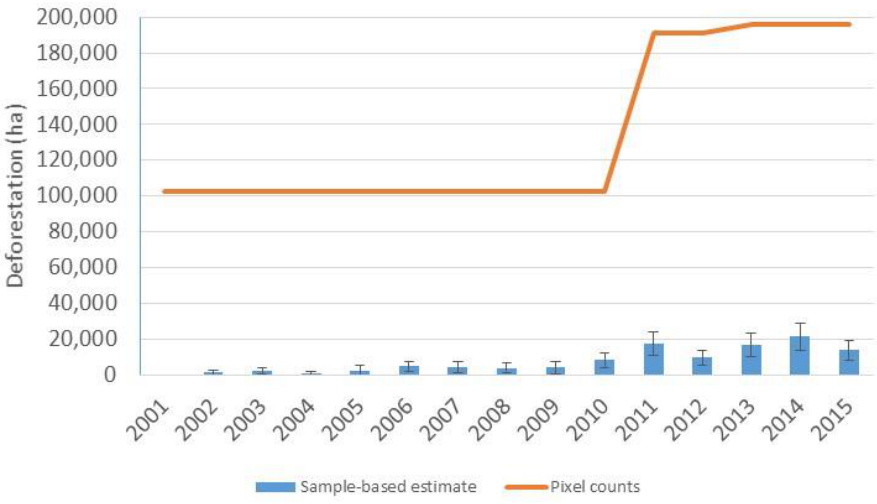
Figure 3. Ghana’s deforestation assessment based on pixel counts and sample-based methodology generated from data in Ghana’s initial and recalculated reference level for the Carbon Fund [30,49]. Ghana’s initial reference level submitted in 2017 for deforestation within the cocoa landscape was 27.7 million tCO 2 /year. The recalculated reference level [30], subject to validation, is 4.1 million tCO 2 /year.